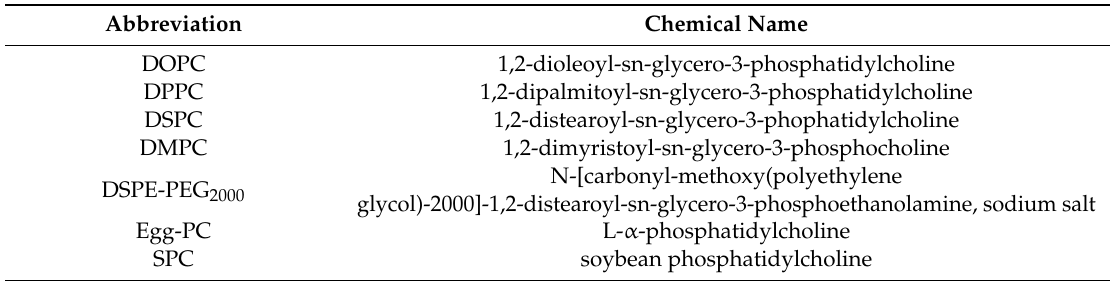
Table 2. List of phospholipids mentioned in the paper with their full chemical